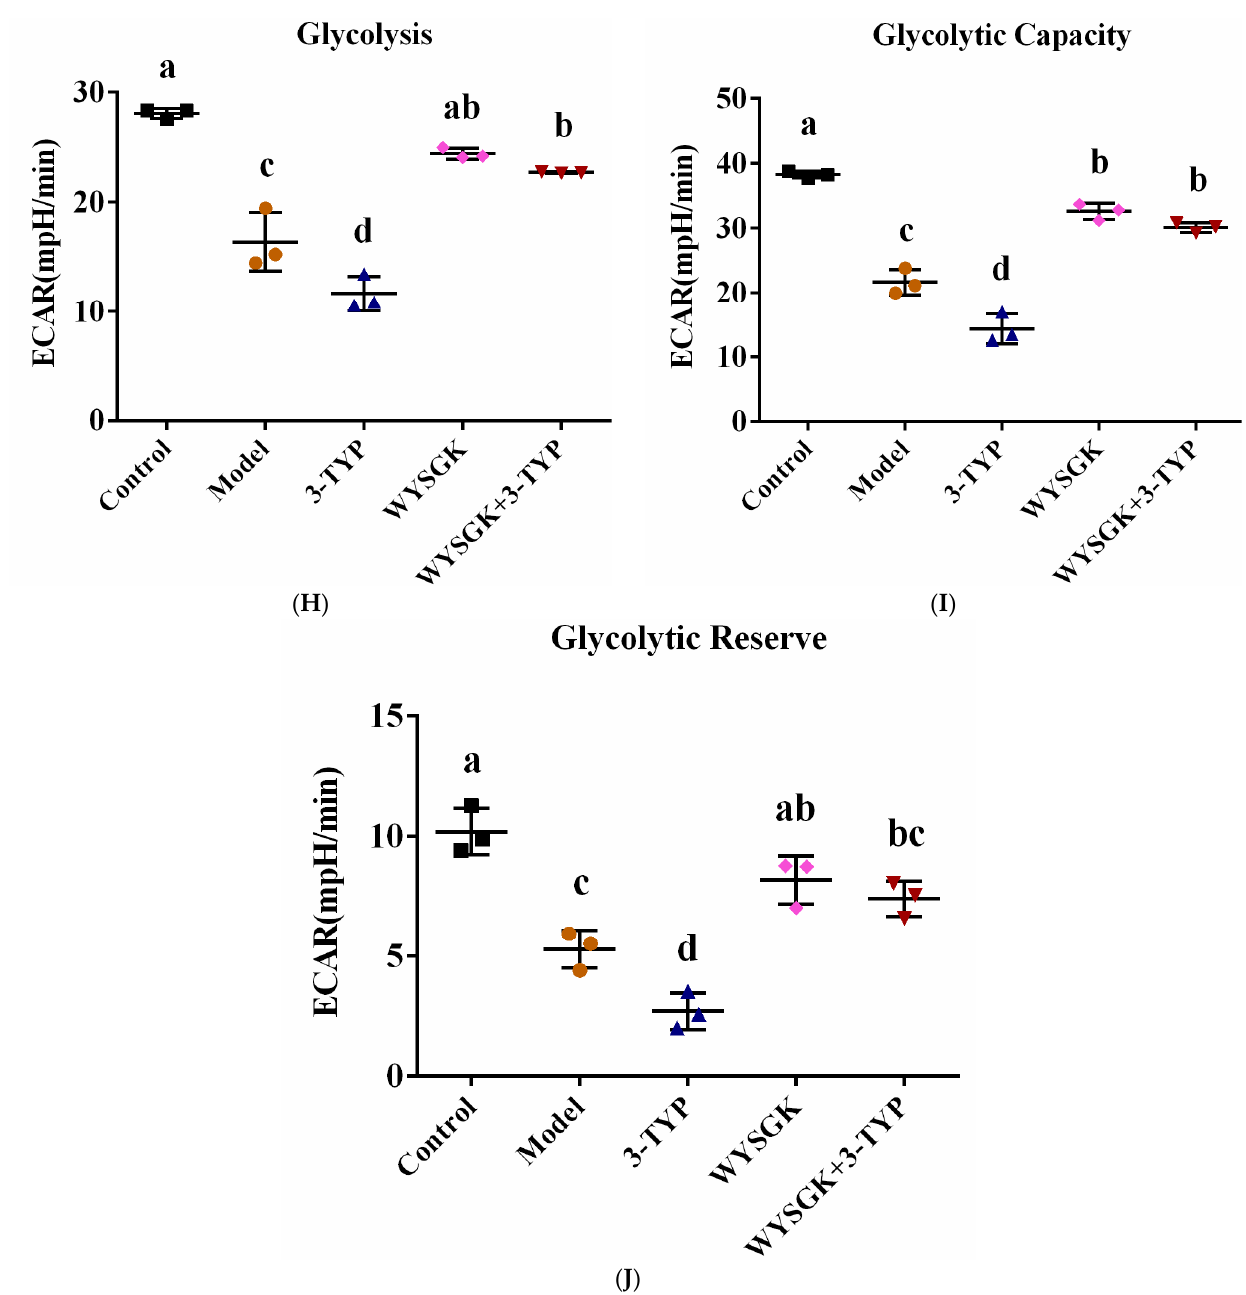
Figure 5. Effects of WYSGK on the cellular oxygen consumption rate (OCR) and extracellular acidification rate (ECAR). Mitochondrial energy metabolism was measured using a Seahorse XF8 extracellular flux analyzer. The mitochondrial ( A ) OCR curve, ( B ) basal respiration, ( C ) ATP production, ( D ) proton leak, ( E ) maximal respiration, and ( F ) spare respiratory capacity. The mitochondrial ( G ) ECAR curve, ( H ) glycolysis, ( I ) glycolysis capacity, and ( J ) glycolysis reserve. Data are presented as means ± SD from three replicates. Different letters denote statistically significant differences ( p < 0.05).